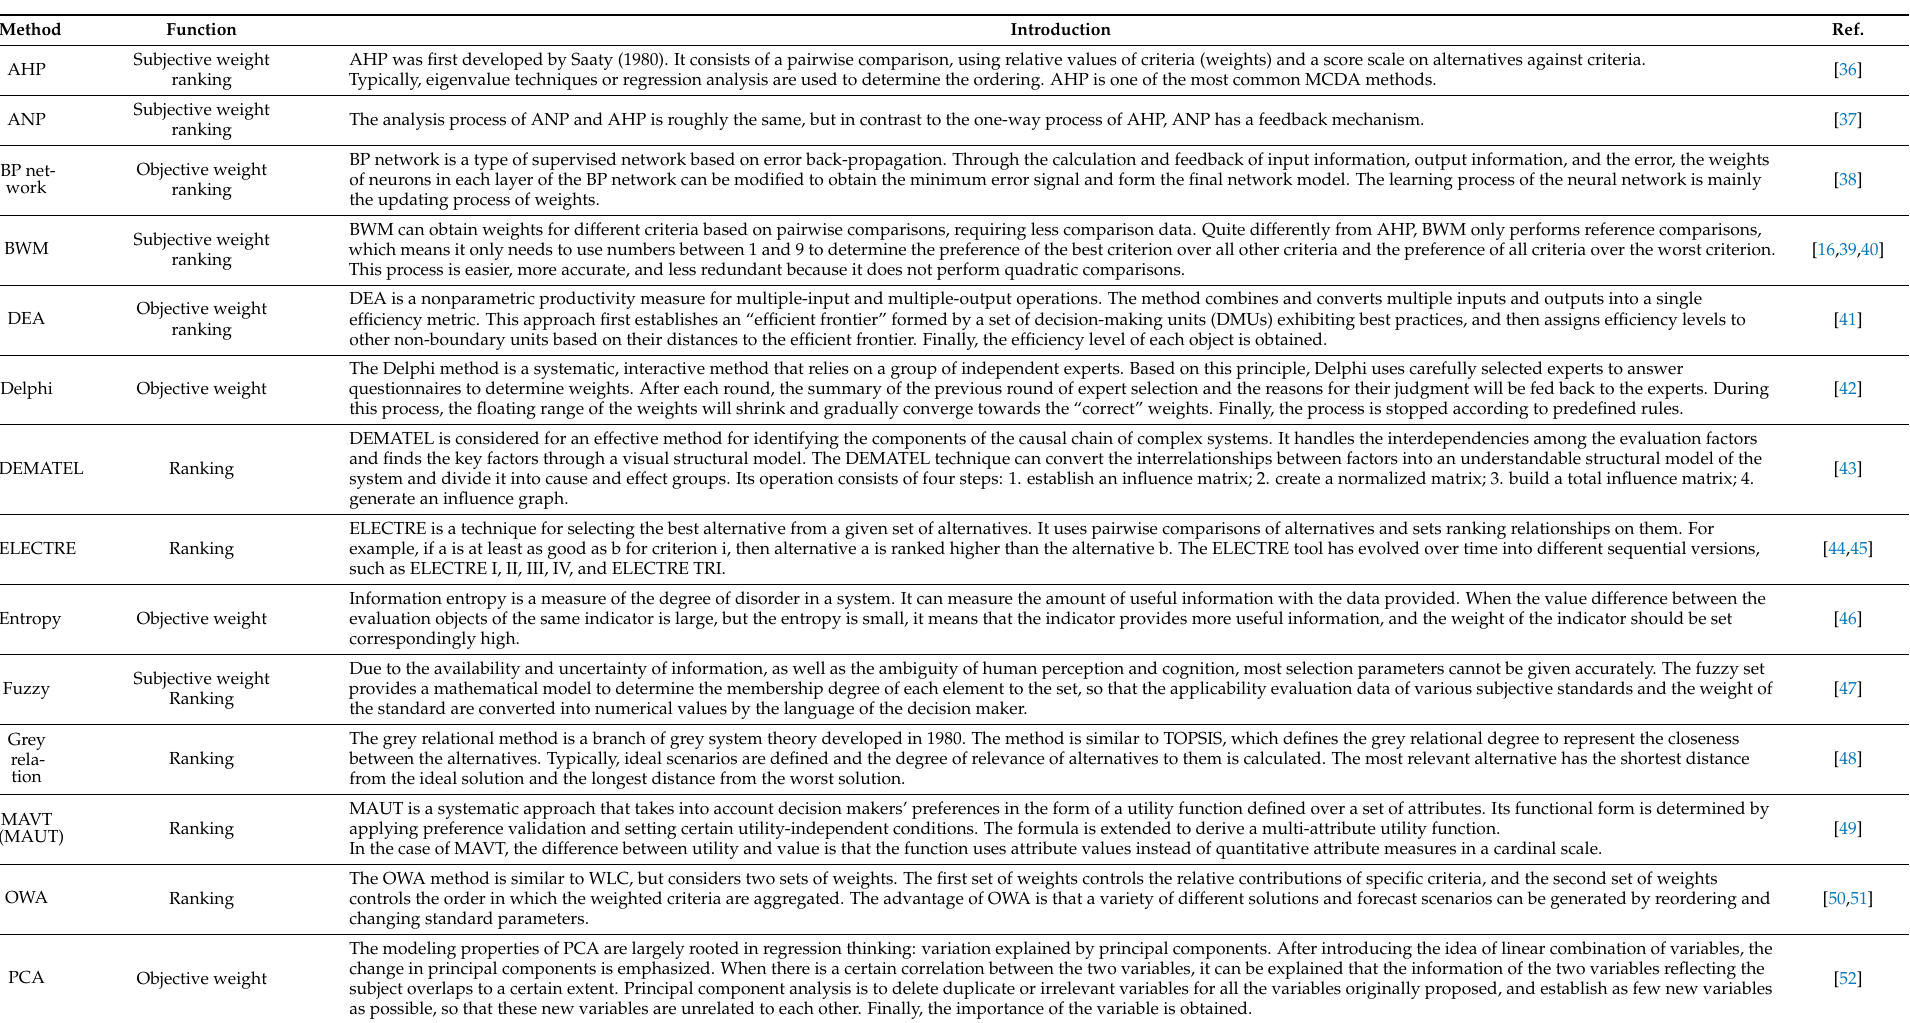
Table 2. Classification of MCDA methods based on functional